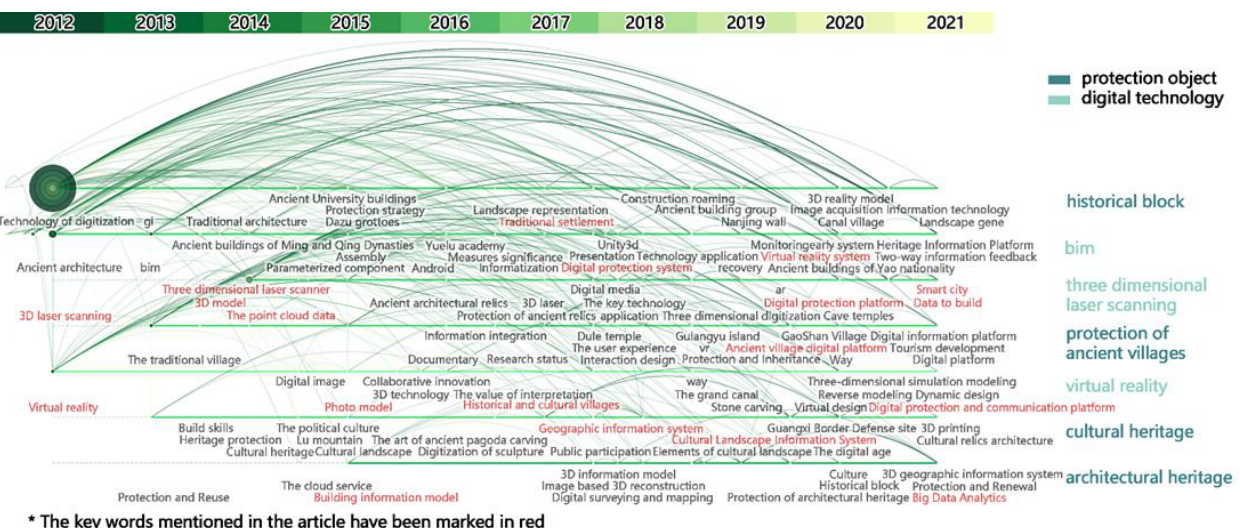
Figure 6. Development trend and evolution mechanism of digital technology for landscape architecture heritage protection over the last 10 years. It can be seen that a single technology was applied to a single object at the beginning. In other words, from 2012 to 2014, 3D laser scanning technology was mostly used for single objects, such as traditional buildings (ancient temples, cemeteries, ancestral halls,